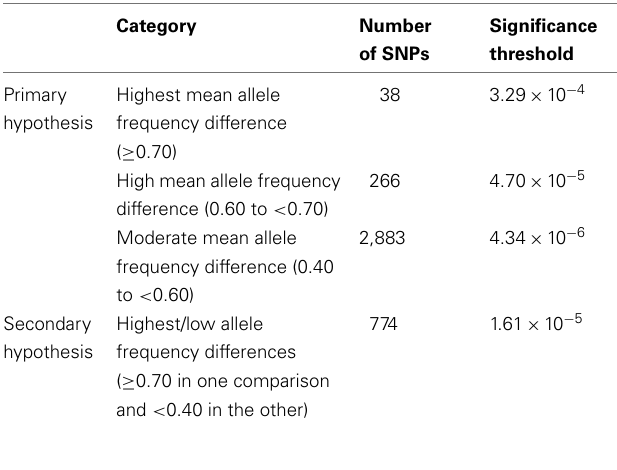
Table 2 | Number of selected SNPs by allele frequency difference category with corresponding Bonferroni-adjusted significance